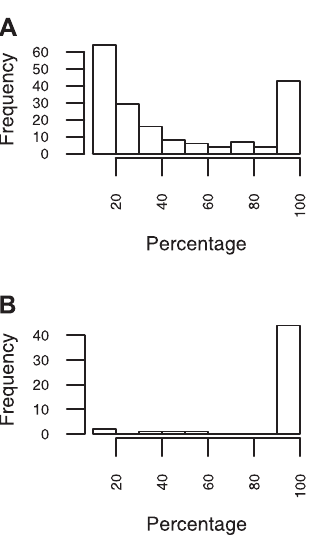
Figure 9. Step 1 of the Mapping Phase in the Comparison of S. flexneri 2457t and S. typhi ty2 Histograms of the percentage of intersection (horizontal axis) between entries of the comprehensive table and transposable elements (A) and between entries of the comprehensive table and phages (B). See Figure 3 and Step 1: Removing trivial entries and selfish DNA. DOI: